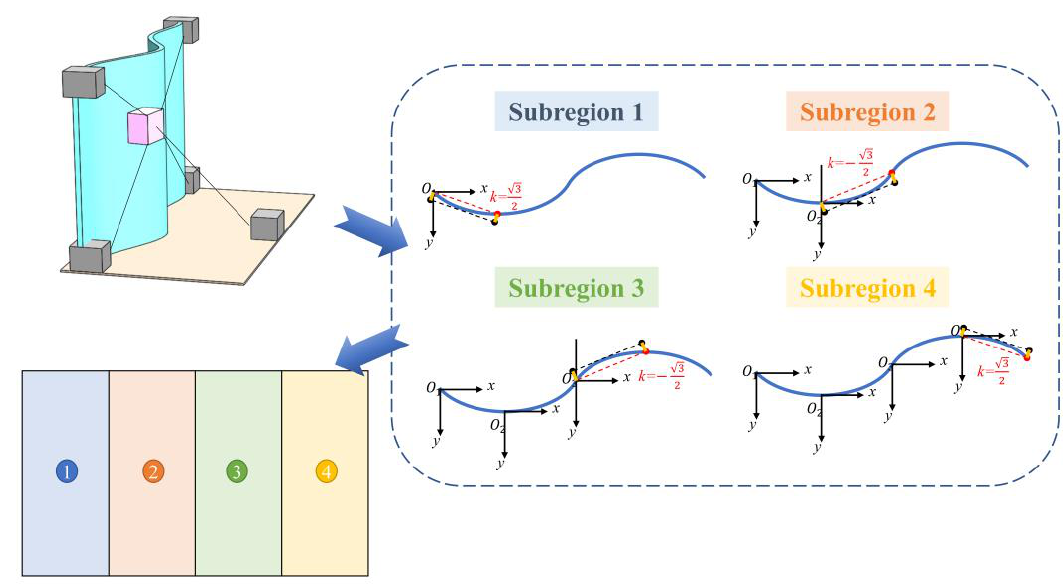
Figure 7. Region decomposition.